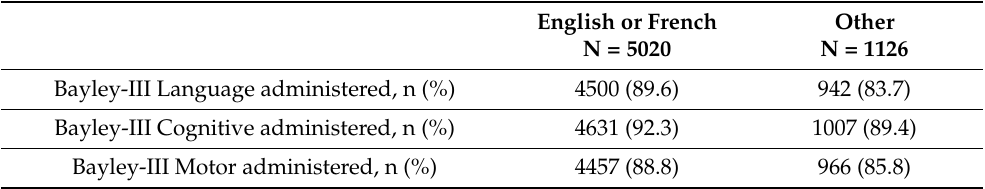
Table 2. Frequency of administering the Bayley-III components by primary language groups.